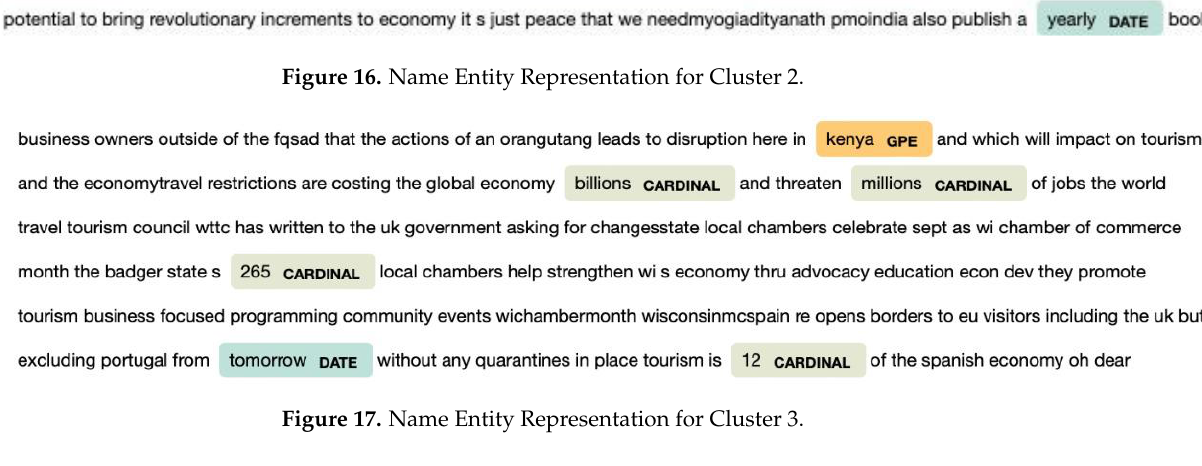
Figure 16. Name Entity Representation for Cluster 2.